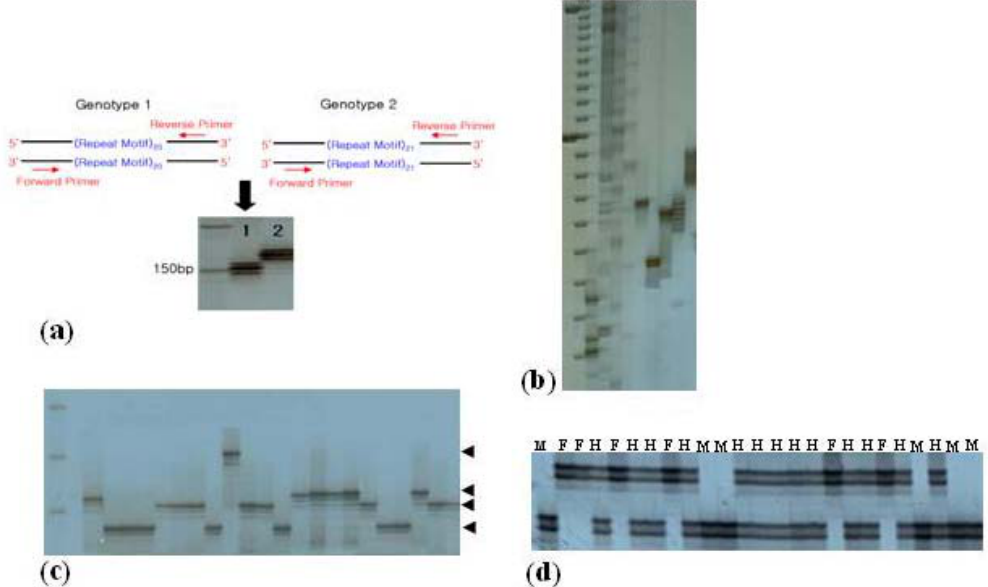
Figure 1. SSR amplification